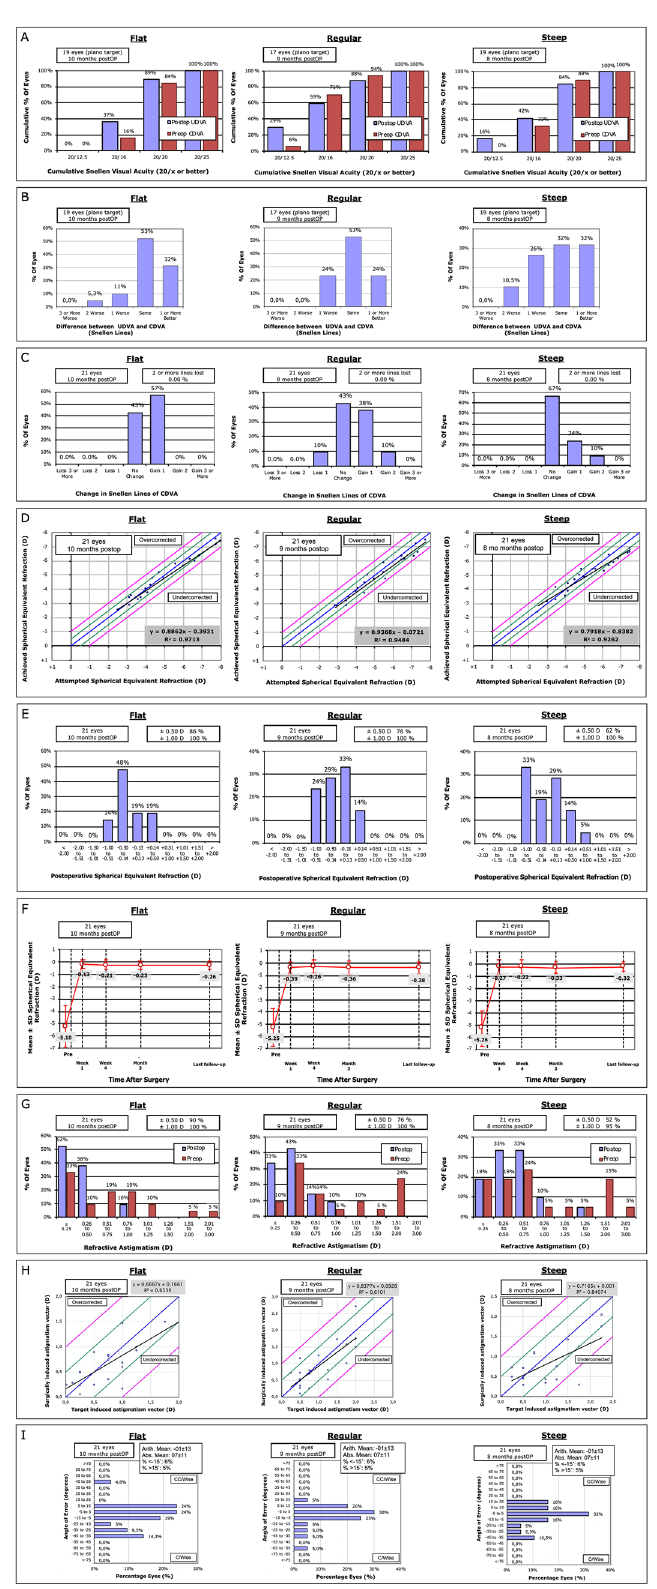
Figure 2. Nine standard graphs for reporting refractive outcomes. ( A ) Efficacy—uncorrected distance visual acuity (UDVA). ( B ) UDVA vs CDVA—comparison of uncorrected to preoperative corrected distance visual acuity. ( C ) Safety (Change in CDVA). ( D ) Attempted vs Achieved Spherical Equivalent Refraction. ( E ) Accuracy of Spherical Equivalent Refraction. ( F ) Stability of Spherical Equivalent Refraction. ( G ) Amplitude of Astigmatism. ( H ) Target induced astigmatism (TIA) vs surgically induced astigmatism (SIA). ( I ) Angle of